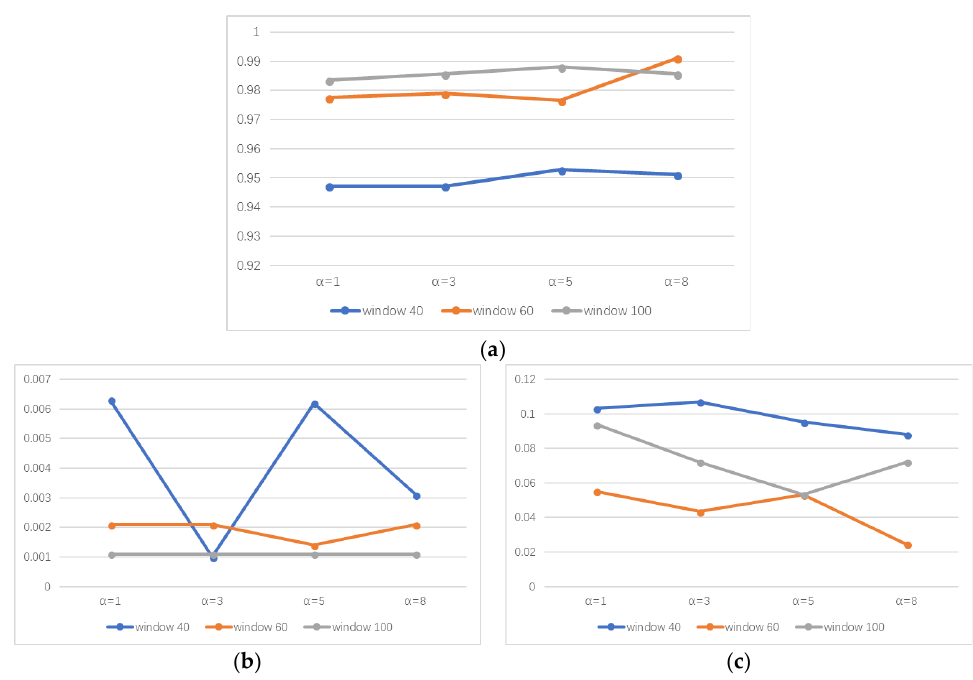
Figure 6. Comparison diagram of performance Indices of each order of HMM-R under different windows. ( a ) Comparison of RP of HMM-R; ( b ) comparison of FA of HMM-R; ( c ) comparison of DR of HMM-R.